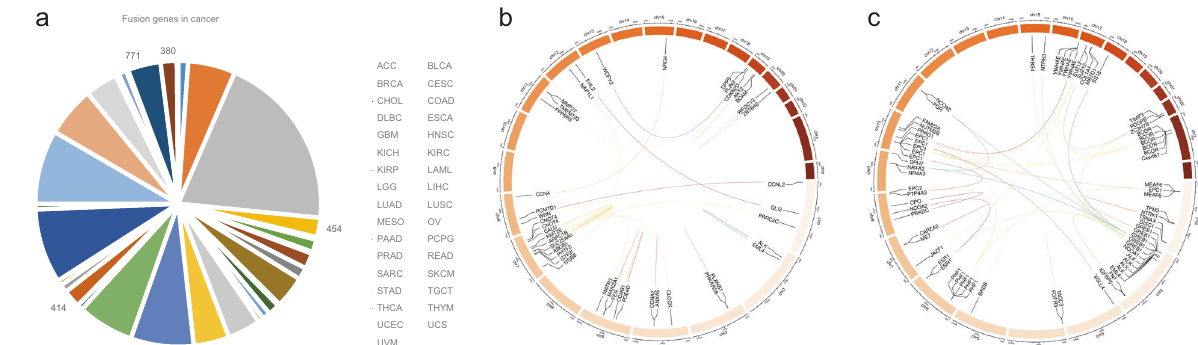
Fig. 1 Gene fusions in gynecological tumors. The pie chart shows the number of gene fusions in different types of cancer ( a ). The data comes from the Tumorfusion database. The circos diagram shows the fusion gene on the chromosome in gynecological tumors ( b ), ( c ). Bioinformatic analysis was performed using the OmicStudio tools at